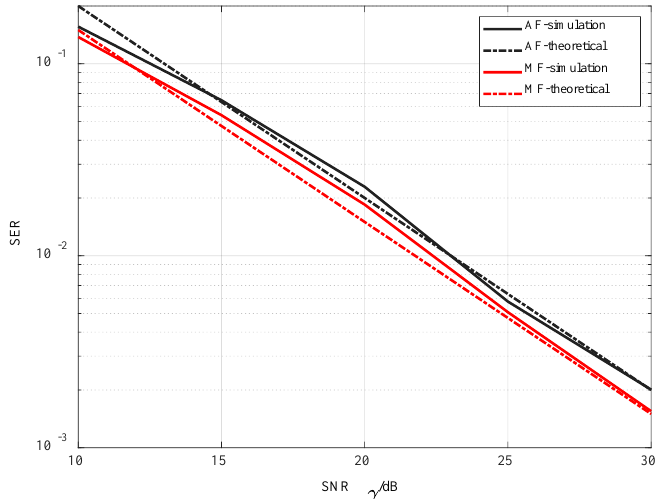
Figure 3. Symbol error rate (SER) performance comparison of different forwarding schemes over the flat Rayleigh fading channel.